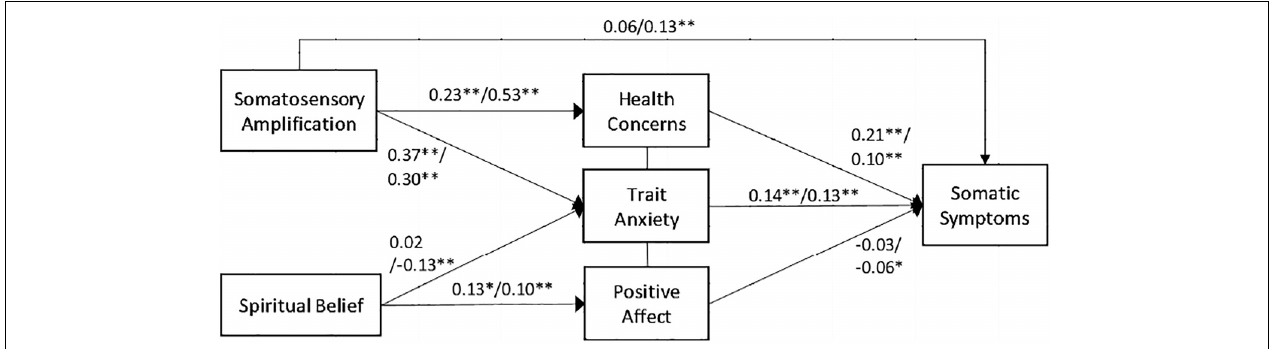
FIGURE 1 | Model of affective state, subjective body perception, and spiritual belief with somatic symptoms. The Japanese participants are mentioned first followed by the Indonesian participants. * p < 0.05, ** p <